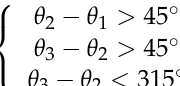
each sector based on polar coordinates. It can be seen there are great differences in coverage areas between the two different